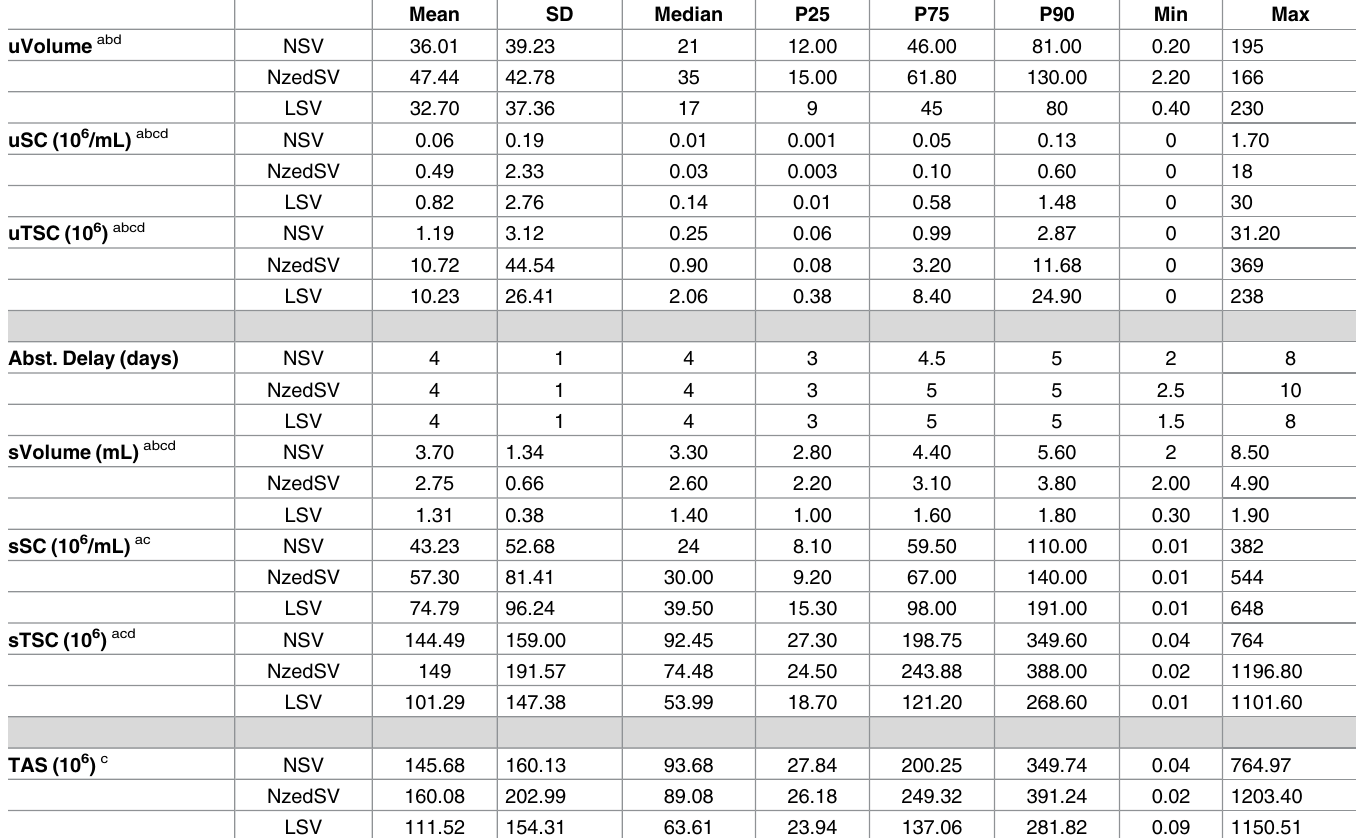
Table 1. Post ejaculatory urine and semen characteristics in the 162 patients with normal semen volume (NSV), 99 patients with normalized semen volume (NzedSV) and 146 patients with observed low semen volume (LSV) according to WHO 1999 [16].